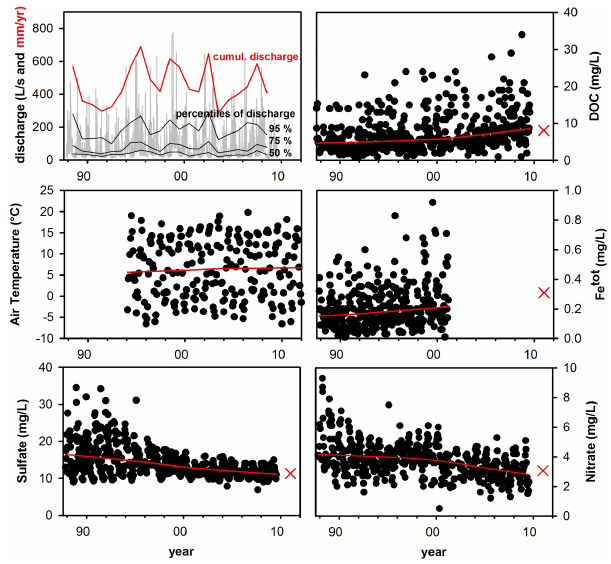
Fig. 2. Discharge, DOC concentrations, air temperature, total iron (Fe tot ) , sulfate and nitrate concentrations at the catchment outlet (near “Schl¨oppnerbrunnen”). Temperature data was recorded at the site “Coulissenhieb” and provided by the Department of Microme- teorology (Prof. Foken, University of Bayreuth). Solute chemistry (filled dots) is from the long-term record of the Bavarian Federal Environmental Authority (unpublished). The red line trend was de- rived by LOWESS regression; the thin X marks the median of the one year measurement campaign results of this study as a rough es- timate for the current trend. The time scale is similar in all graphs (1 August 1987–1 January 2011) to facilitate comparison, although not all data was available for the displayed period. Increase of Tem- perature from LOWESS: 5.63 ◦ C (1994) to 6.75 ◦ C (2012), DOC (LOWESS): 4.68 (1987) to 8.57mgL − 1 (2009), iron: 0.15 (1987, LOWESS) to 0.30mg L-1 (Median 2010–2011, see Table 1); de- crease of sulfate (LOWESS): 16.48 (1987) to 11.14mgL − 1 (2009), nitrate (LOWESS): 4.17mgL − 1 (1987) to 2.80mgL − 1 (2009). No significant trends in the percentiles of discharge or in cumulated discharge (Mann-Kendall, sigma >